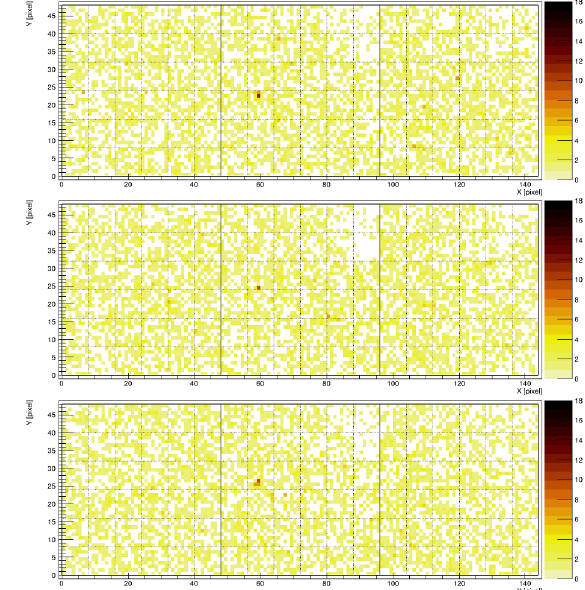
Figure 14: Example frames, each 1 µ s, of a laser track crossing the camera of the FT on 31 / 08 / 2022 at 06:27:10. The color bar shows the photoelectron count on the focal surface. The laser energy was set to 1.8 mJ and the laser at a distance of 24 km was pointed straight upwards while the telescope was pointed upwards by 7 ◦ from horizontal.